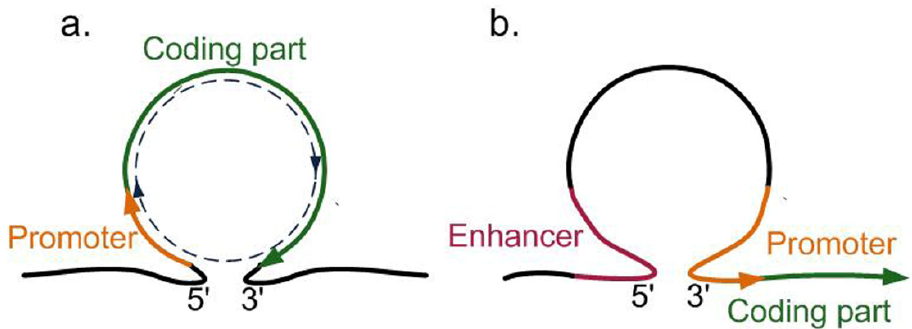
Figure 4. Chromatin loops increasing the transcriptional activity of genes: ( a ) the loop between 5’UTR and 3’UTR, allowing RPol II to move in a circle; and ( b ) the loop between a distant enhancer and a promoter.